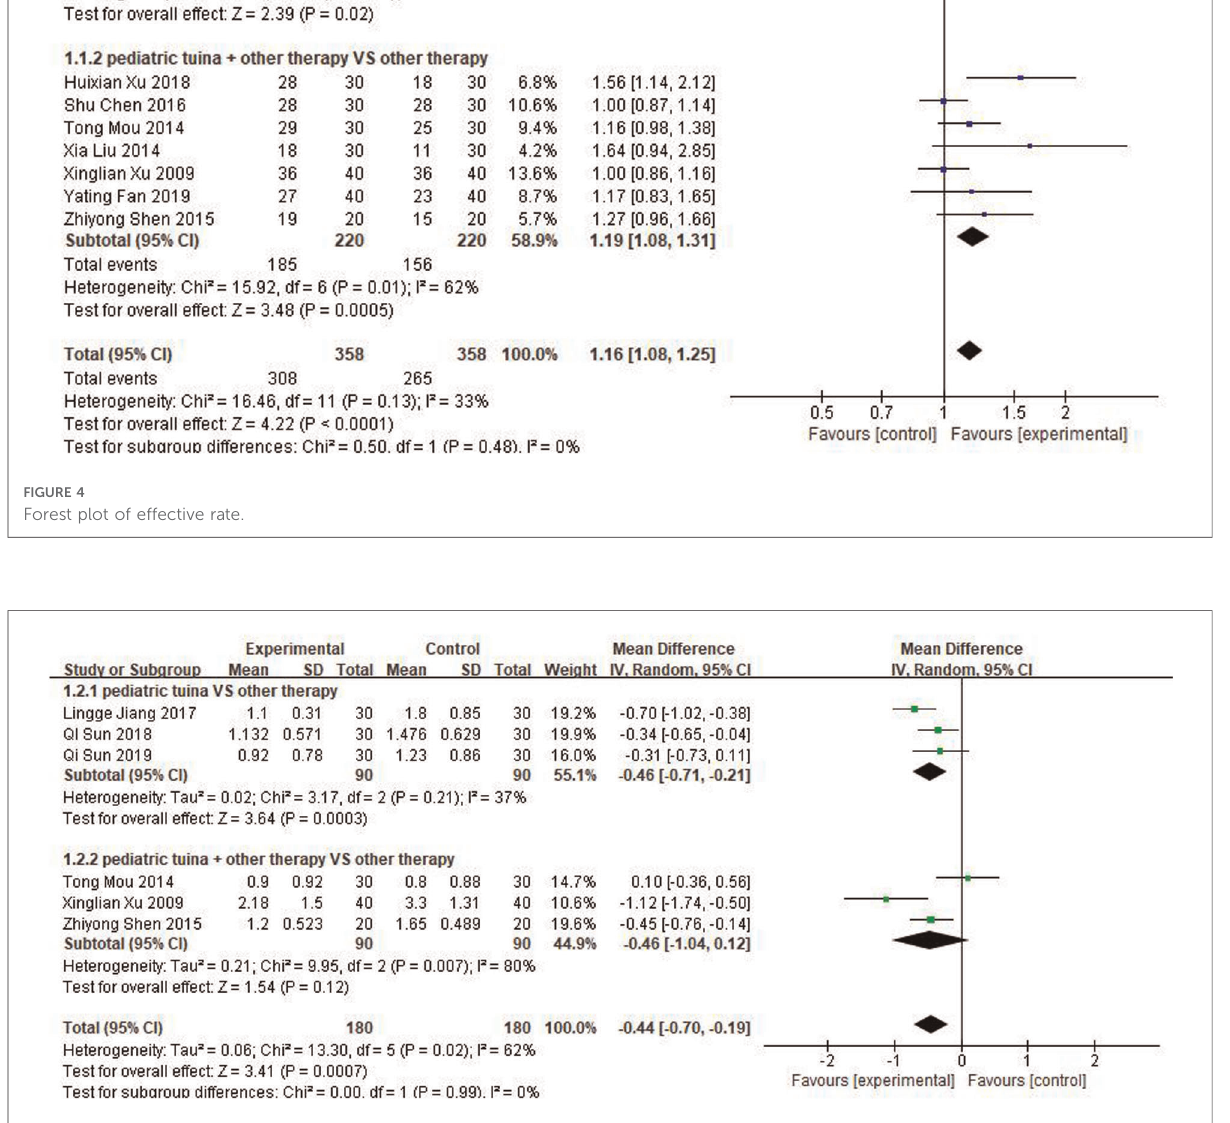
FIGURE 5 Forest plot for the treatment of nasal congestion